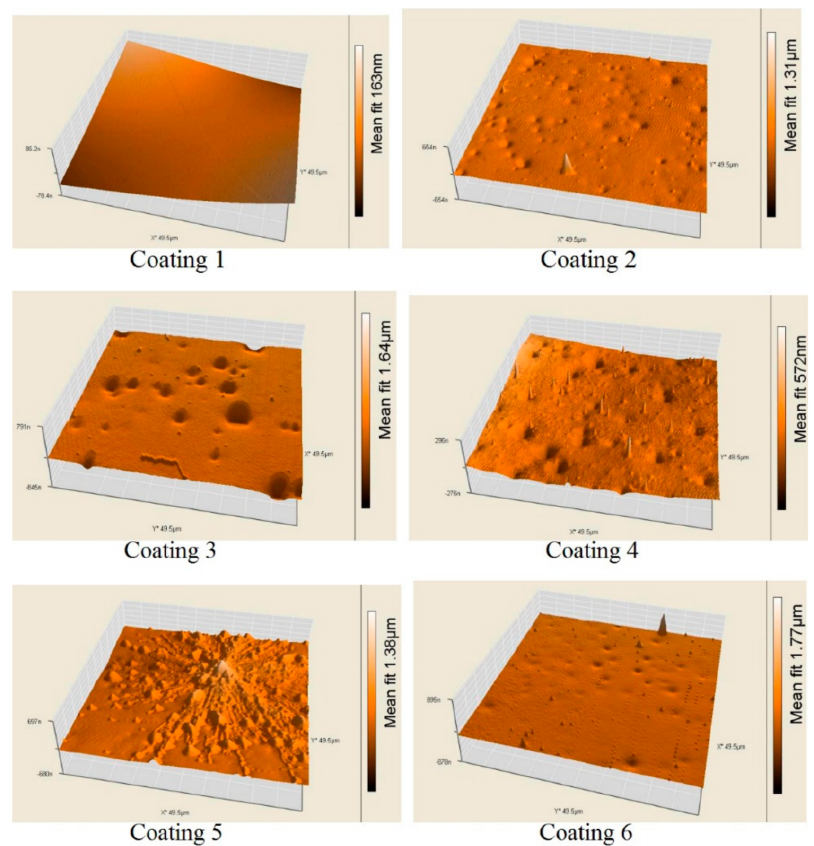
Figure 1. Nano-topography (49 µ m × 49 µ m surface area) of the studied coatings, containing: (1) 6 wt % conventional cross-linker, ES 40 (control); (2) 4 wt % ES40 + 2 wt % PEG-silane; (3) 6 wt % ES40 + 2 wt % PEG-silane; (4) 4 wt % ES40 + 2 wt % PEG-silane + 0.5 wt % NIS; (5) 4 wt % ES40 + 2 wt % PEG-silane + 2.0 wt % AO; (6) 4 wt % ES40 + 2 wt % PEG-silane + 0.5 wt % NIS + 1.5 wt %